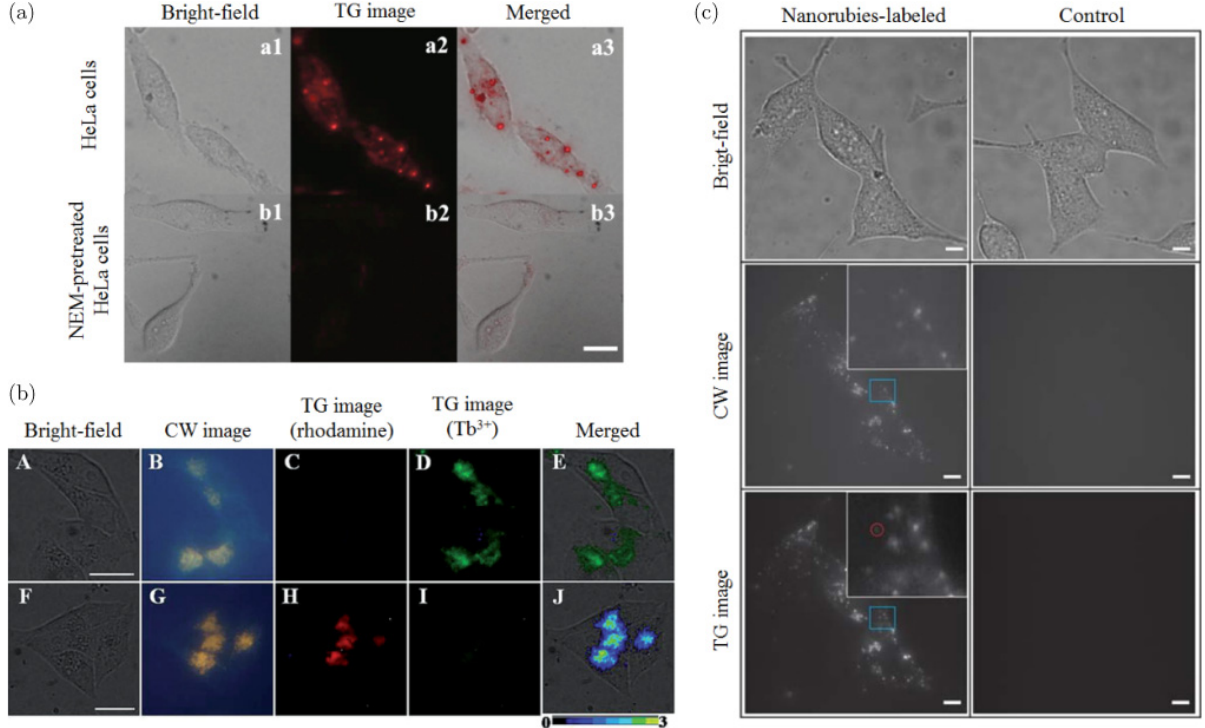
Fig. 8. (a) Images of HeLa cells (top) and NEM-pretreated HeLa cells (bottom, as control experiment) incubated with BHHBB – Eu 3 þ @MnO 2 for 3 h (1: bright-¯eld images; 2: TG images; 3: merged images of 1 and 2). Scale bar: 10 (cid:3) m. (b) Bright-¯eld (A and F), CW (B and G), and TG (C and H for rhodamine luminescence, and D and I for Tb 3 þ luminescence) images of the TRP-NO-loaded HeLa cells before (top) and after (bottom) incubation with nitric oxide. Image E is the merged image of A and D, and image J is the merged image of F and a ratiometric (ratio ¼ H/I) luminescence image. Scale bar: 10 (cid:3) m. (c) Bright ¯eld, CW, and TG images of AtT-20 cells incubated with nanorubies (left column) and control (right column), respectively. Scale bar: 10 (cid:3) m. Reprinted with permission from Refs. 36, 75, and